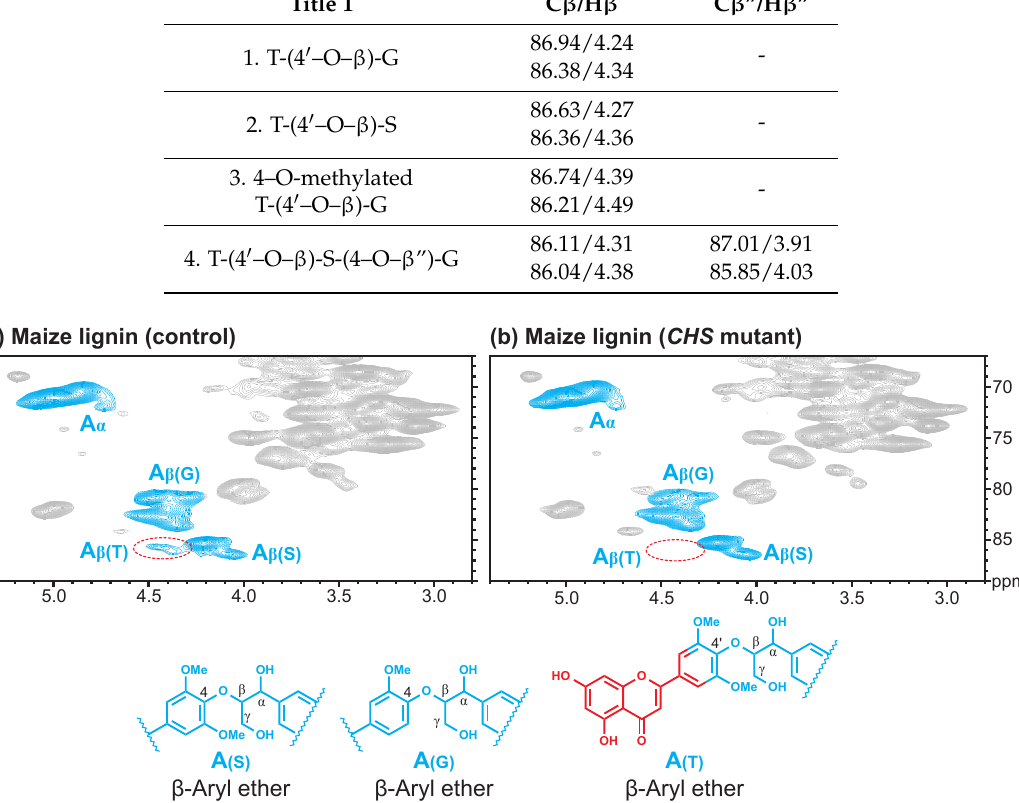
Figure 2. HSQC spectra of enzymatic lignin from control ( a ) and chalcone synthase (CHS) mutant ( b ) maize